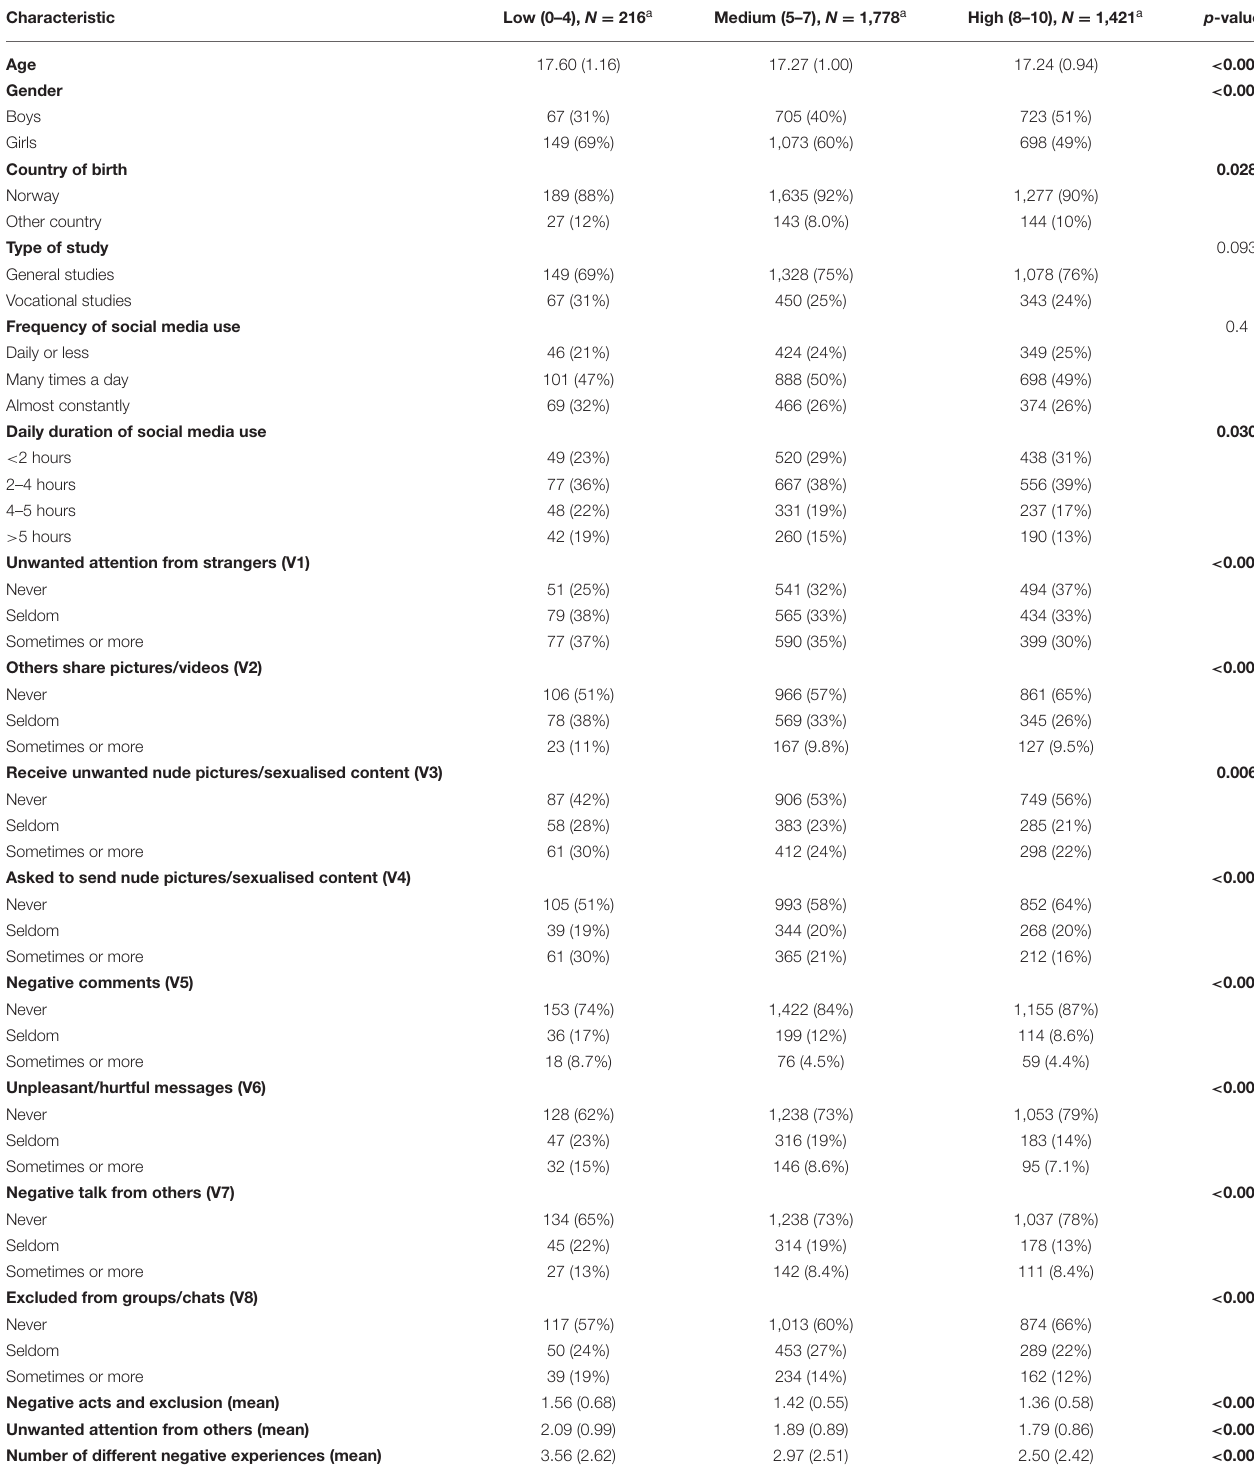
TABLE 1 | Description of included variables across subjective socioeconomic